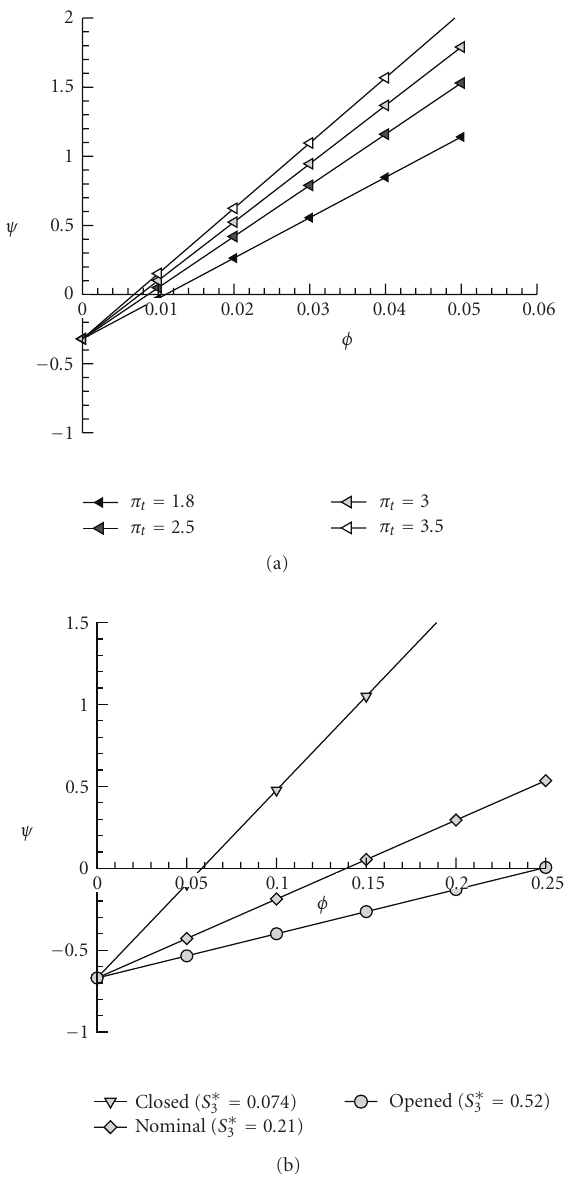
Figure 3: Pressure-ratio line prediction for (a) TS1 and (b) TS2 .